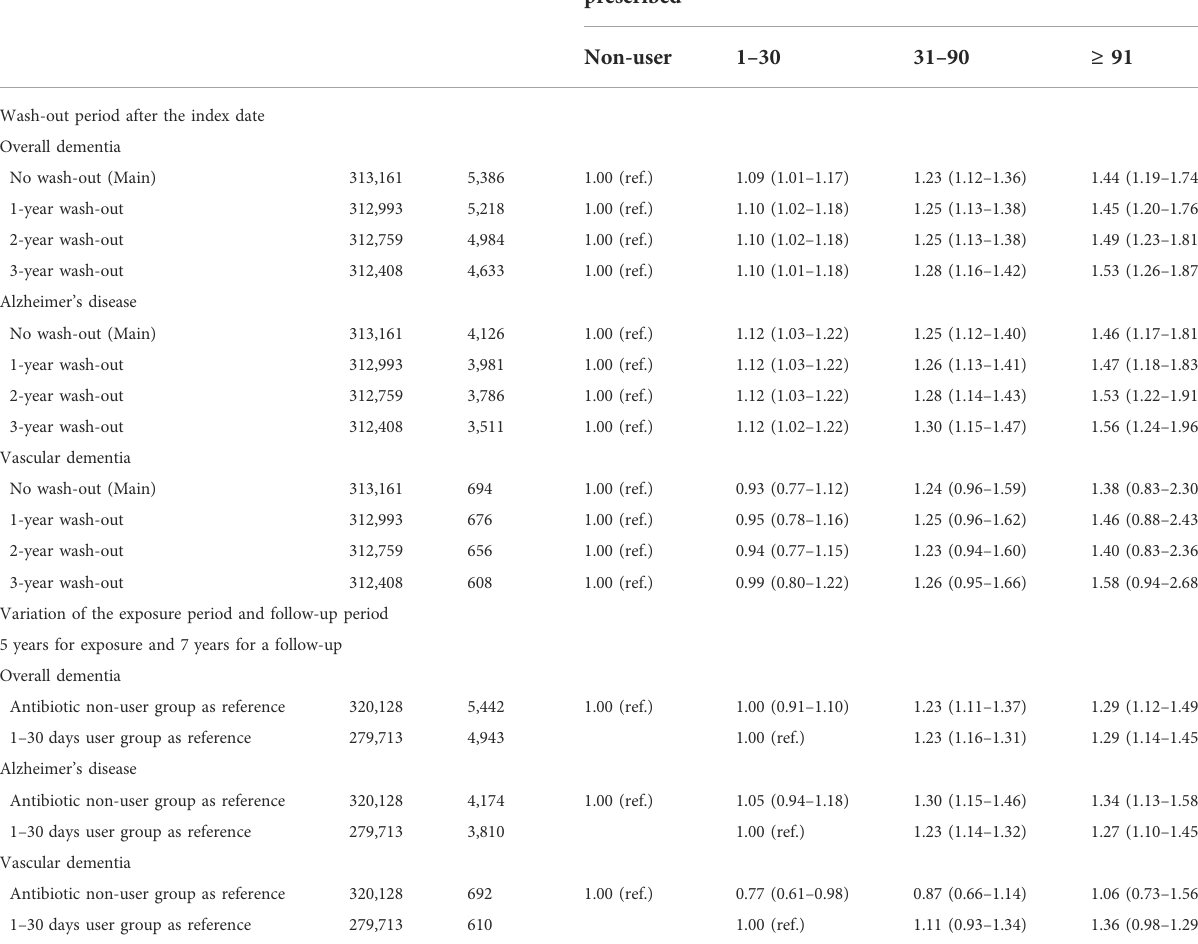
TABLE 3 Sensitivity analyses of the association between antibiotic exposure and dementia